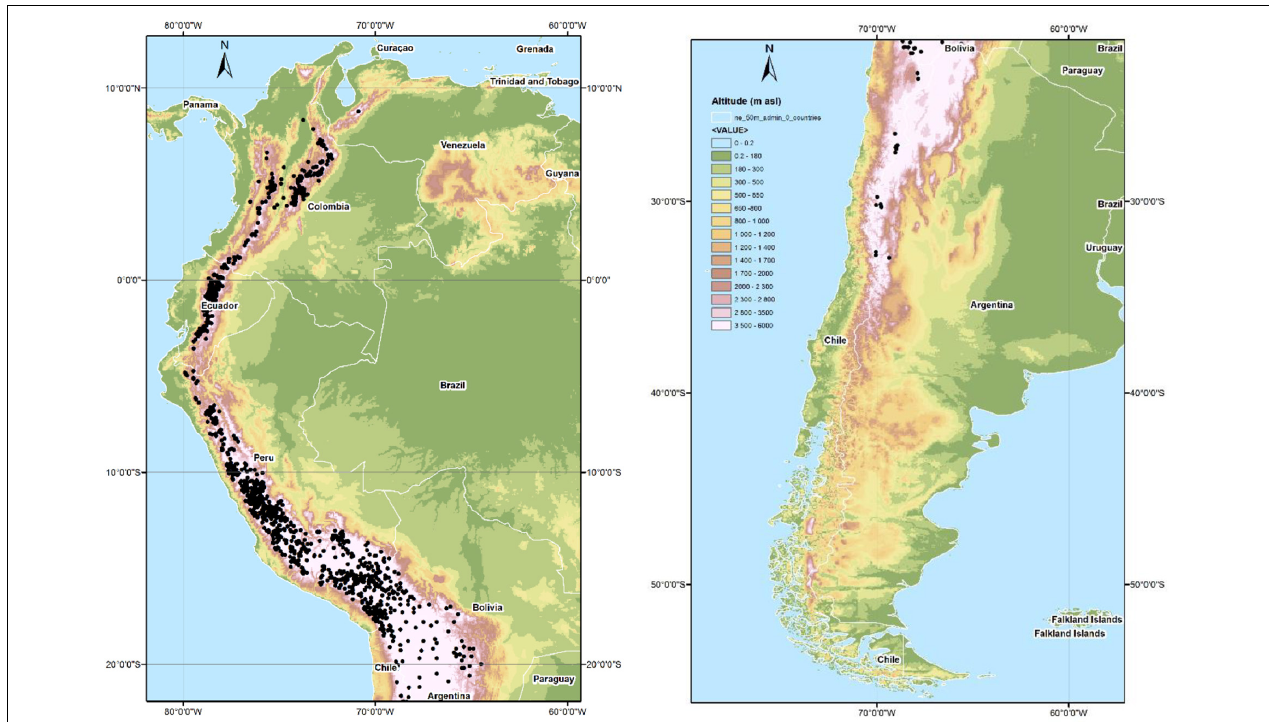
FIGURE 4 | Total number of surface stations (meteorological and hydrological) above 3000 m. Source: National Meteorological and hydrological Services from Bolivia, Chile, Colombia, Ecuador, Peru, and